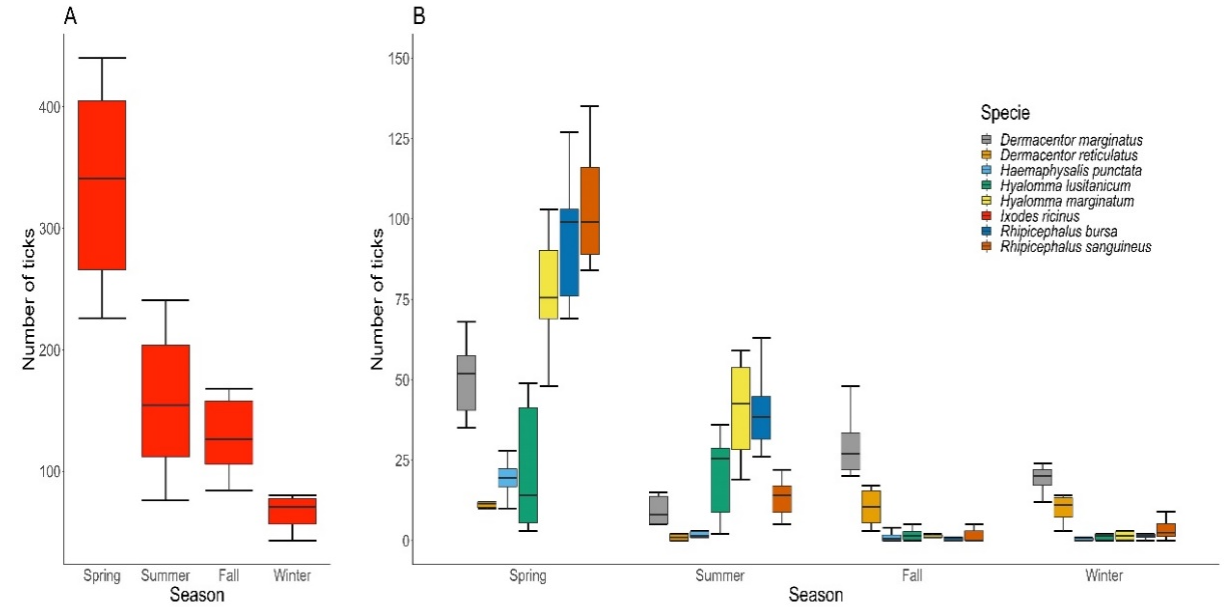
Figure 4. Seasonality of tick bites on humans. ( A ) I. ricinus . ( B ) D. marginatus, D. reticulatus, H. punc- tata, Hy. Lusitanicum, Hy. Marginatum, R. bursa and R. sanguineus . Species sampled by season